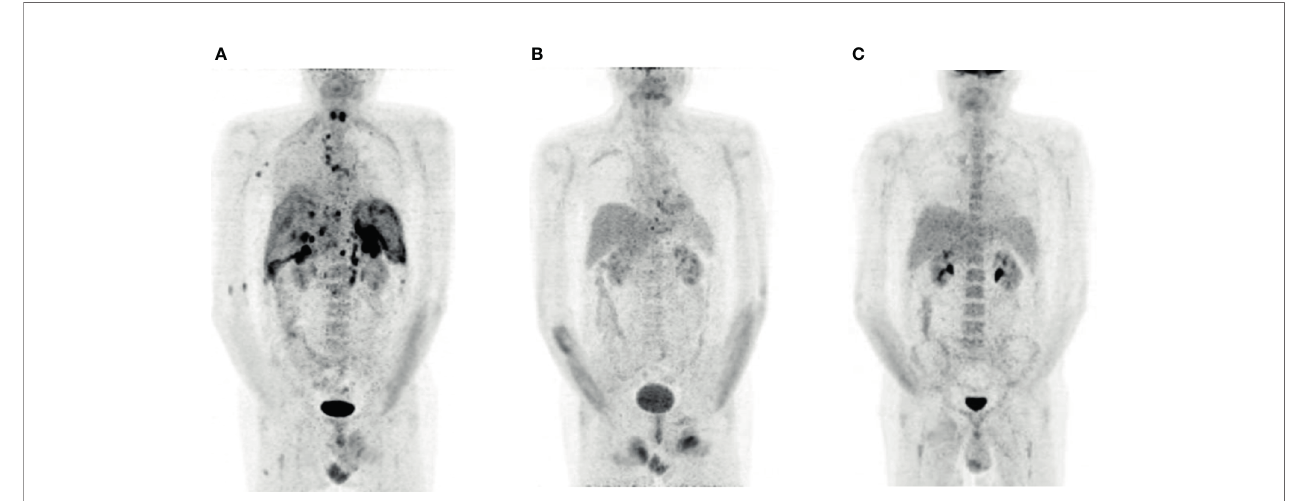
FIGURE 1 | FDG PET imaging patient 1. (A) Relapse 6 months after the therapy with CAR T-cells (prior to Pola-BR). (B) Complete metabolic remission after three courses of Pola-BR. (C) Con fi rmed complete metabolic remission 12 weeks after